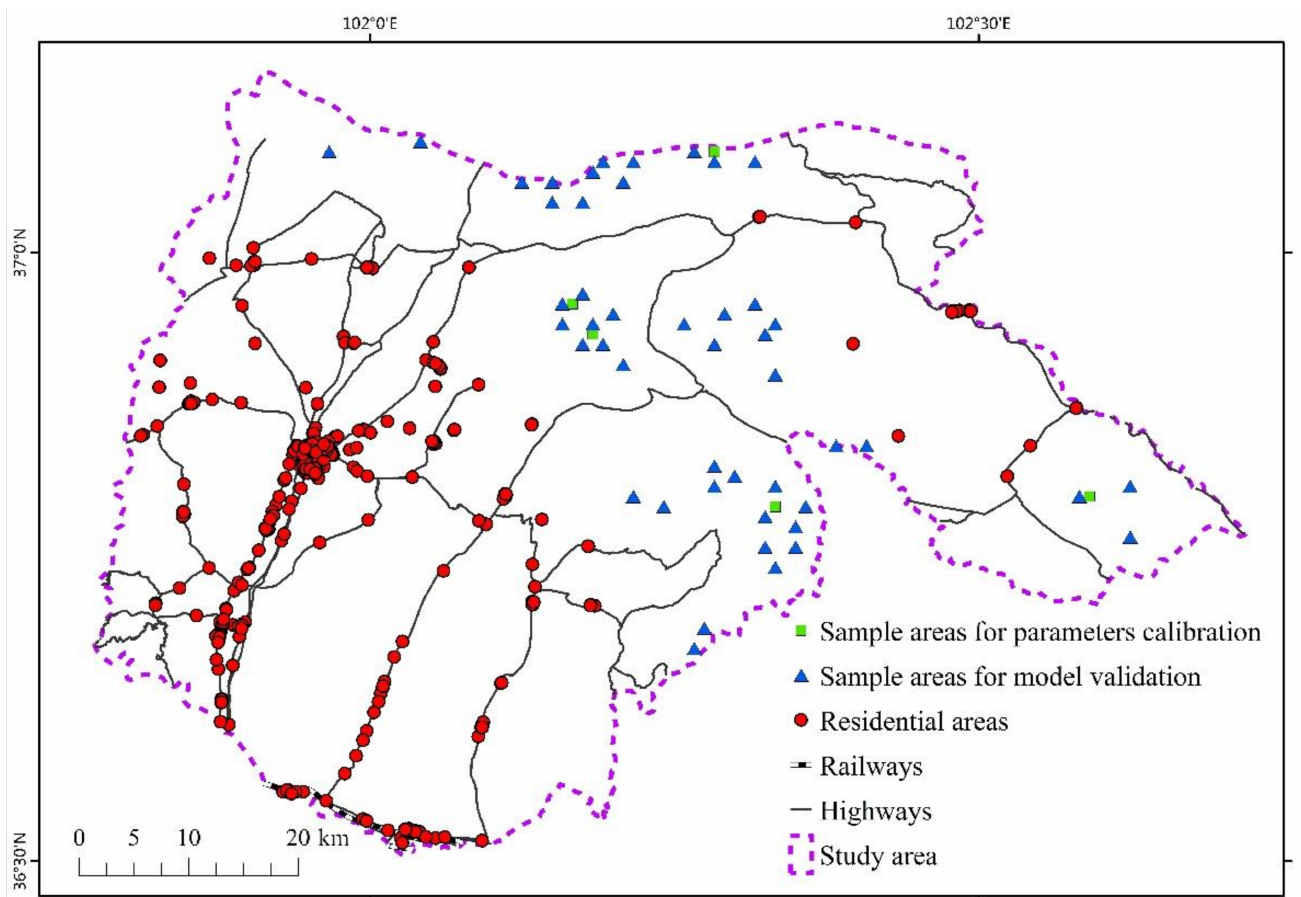
Figure 2. Sampling areas for calibration of parameters, and model